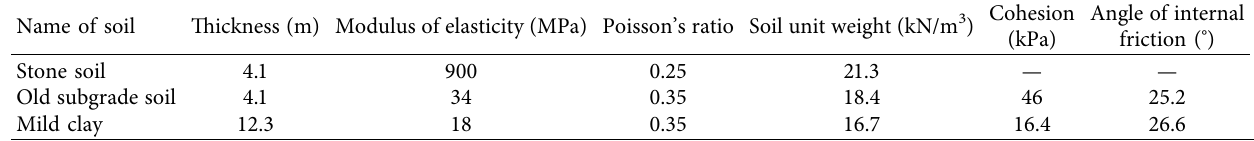
Table 1: Stone soil, old subgrade soil, and mild clay parameters